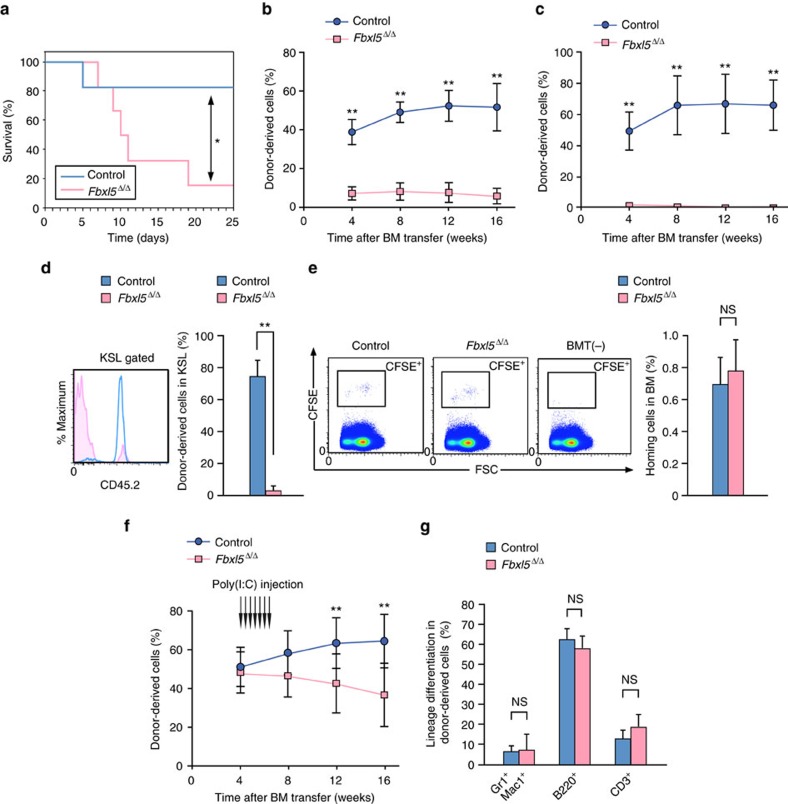
Cellular iron overload impairs the repopulation capacity of HSCs.(a) Survival of lethally irradiated mice transplanted with BM cells (1 × 106) from Fbxl5Δ/Δ or control mice (n=6). (b) Hematopoietic repopulation capacity of Fbxl5Δ/Δ or control BM cells (4 × 105) transplanted together with an equal number of competitor cells. The percentage of donor-derived cells in PB of recipient mice was determined at the indicated times after BM transfer from Fbxl5Δ/Δ (n=7) or control (n=8) mice. (c) BM cells (1 × 106) from the recipient mice in b at 16 weeks after BM transfer were serially transplanted into additional recipient mice (Fbxl5Δ/Δ, n=6; control, n=5), and the percentage of donor-derived cells in PB of the new recipients was determined at the indicated times thereafter. (d) The percentage of donor-derived cells among KSL cells in BM of the recipients in b was determined at 16 weeks after BM transfer. (e) Homing capacity of CFSE-labelled Fbxl5Δ/Δ or control KSL cells (2 × 104) for BM at 16 h after BM transfer (BMT) (n=3). FSC, forward scatter. (f) Irradiated recipient mice were transplanted with donor BM cells (4 × 105) from Mx1-Cre/Fbxl5+/+ (control) or Mx1-Cre/Fbxl5F/F mice [not injected with poly(I:C)] together with an equal number of competitor BM cells, and they were injected with poly(I:C) beginning 4 weeks after BM transfer. The percentage of donor-derived cells in PB at the indicated times after BM transfer was determined (Fbxl5Δ/Δ, n=9; control, n=10). (g) Frequency of differentiated cells (Gr1+Mac1+ myeloid cells, B220+ B cells, and CD3+ T cells) among donor-derived blood cells for the recipients in f at 16 weeks after BM transfer. Data are means±s.d. *P<0.05, **P<0.01 versus the corresponding value for Fbxl5Δ/Δ or as indicated [log-rank test (a) or Student’s t-test (other panels)].